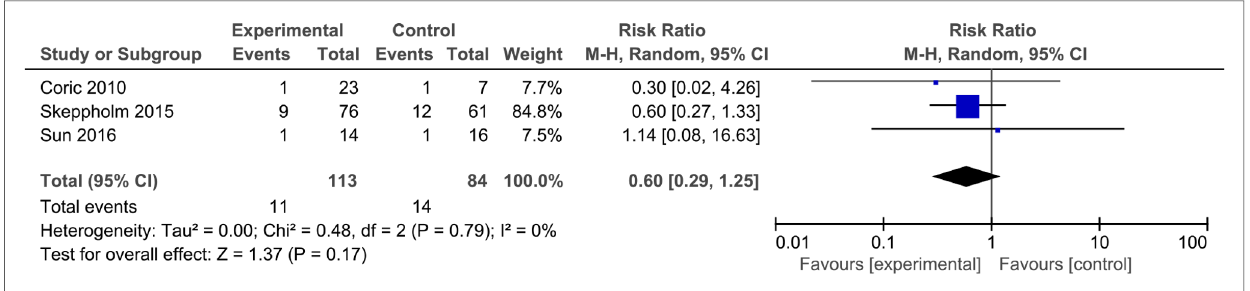
FIGURE 7 Comparison of dysphagia between the discover cervical disc arthroplasty (DCDA, “ experimental ” ) group and the anterior cervical discectomy and fusion (ACDF, “ control ” )